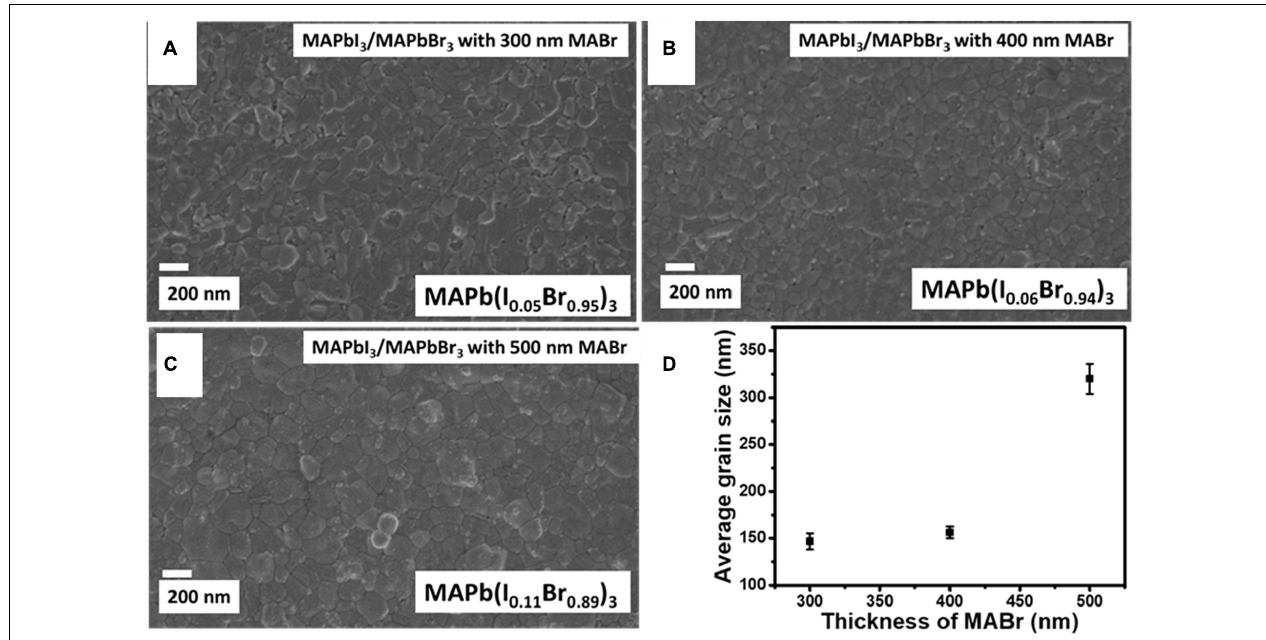
FIGURE 4 | FE-SEM micrographs and average grain size of MAPb(I 1 − x Br x ) 3 thin films for various MABr thicknesses, (A) MAPb(I 0 . 05 Br 0 . 95 ) 3 having 300 nm of MABr, (B) MAPb(I 0 . 06 Br 0 . 94 ) 3 having 400 nm of MABr, (C) MAPb(I 0 . 11 Br 0 . 89 ) 3 having 500 nm of MABr, (D) the average grain size of MAPb(I 1 − x Br x ) 3 thin films for various MABr